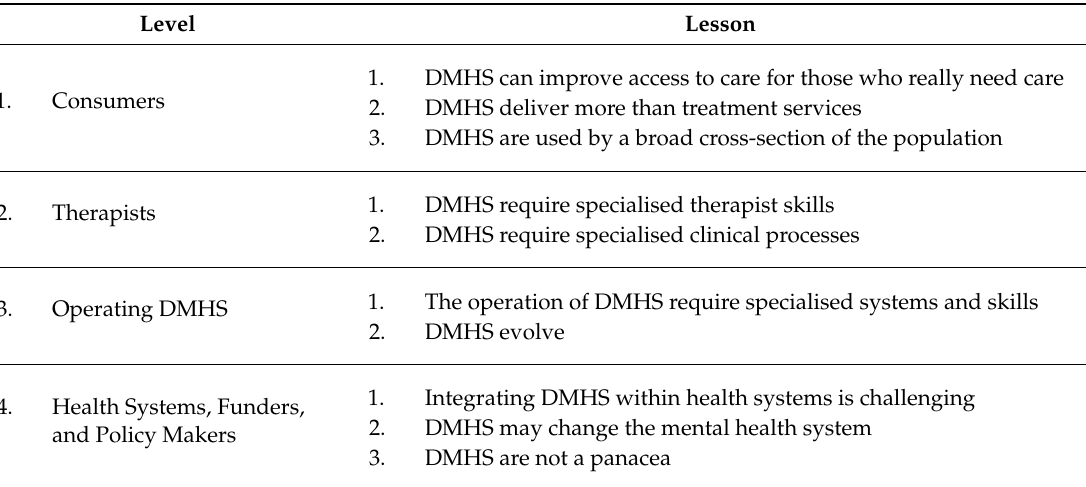
Table 1. Lessons learned at four levels of analysis of digital mental health services